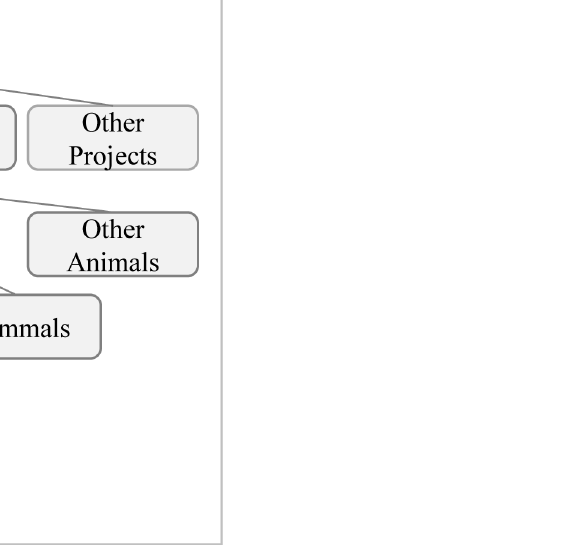
PLOS ONE | DOI:10.1371/journal.pone.0143687 November 23,